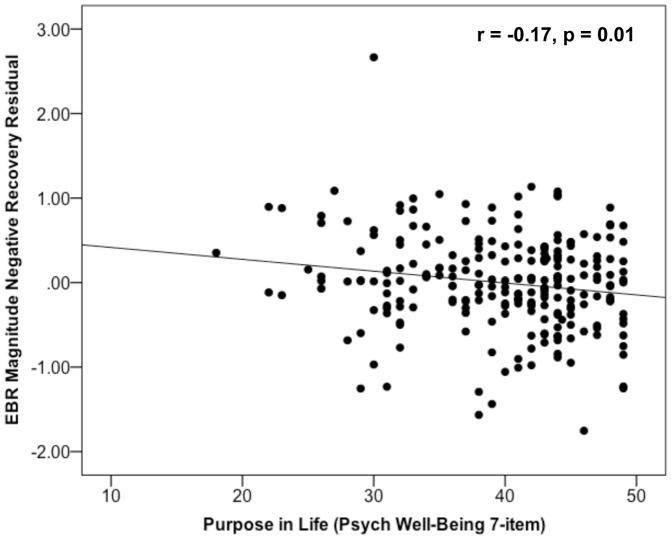
Purpose in life predicts smaller EBR indexing greater recovery after negative picture offset.Note: (1) EBR values are log-transformed and then z-scored within each participant. (2) The EBR recovery measure here reflects EBR magnitude at the recovery probe regressed on EBR magnitude at the reactivity probe, removing variation due to differences in reactivity. (3) The relation remains significant if the outlier is removed: Purpose in life x EBR negative magnitude residual at recovery r = –0.15, p = 0.03.